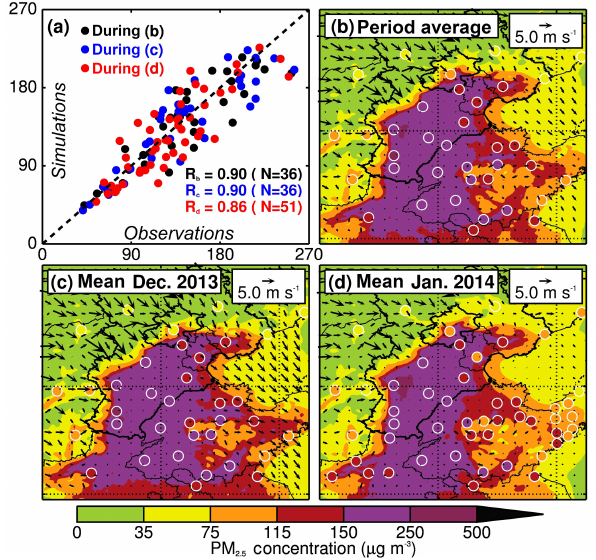
Figure 4. Pattern comparisons of calculated and observed near- surface PM 2 . 5 mass concentrations. (a) Spatial correlation between calculated and observed PM 2 . 5 concentrations during each month and the whole simulation period. Horizontal distribution of calcu- lated (color contour) and observed (colored circles) average PM 2 . 5 concentrations during (b) the whole simulation period, (c) Decem- ber 2013, and (d) January 2014, along with the simulated wind fields (black arrows).